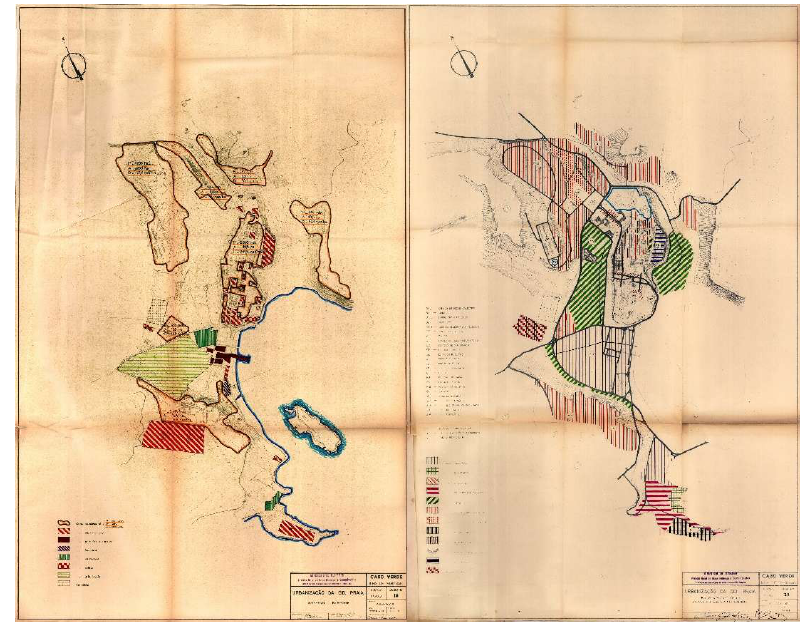
Figure 8. Maria Emília Caria. “City of Praia Urban Development Plan, Santiago Island, Cape Verde, Figure 8. Maria Em í lia Caria. “City of Praia Urban Development Plan, Santiago Island, Cape Verde, Zoning (existing zones and proposed new zones)”, drawings no. 16 (existing) and 21 (proposed),